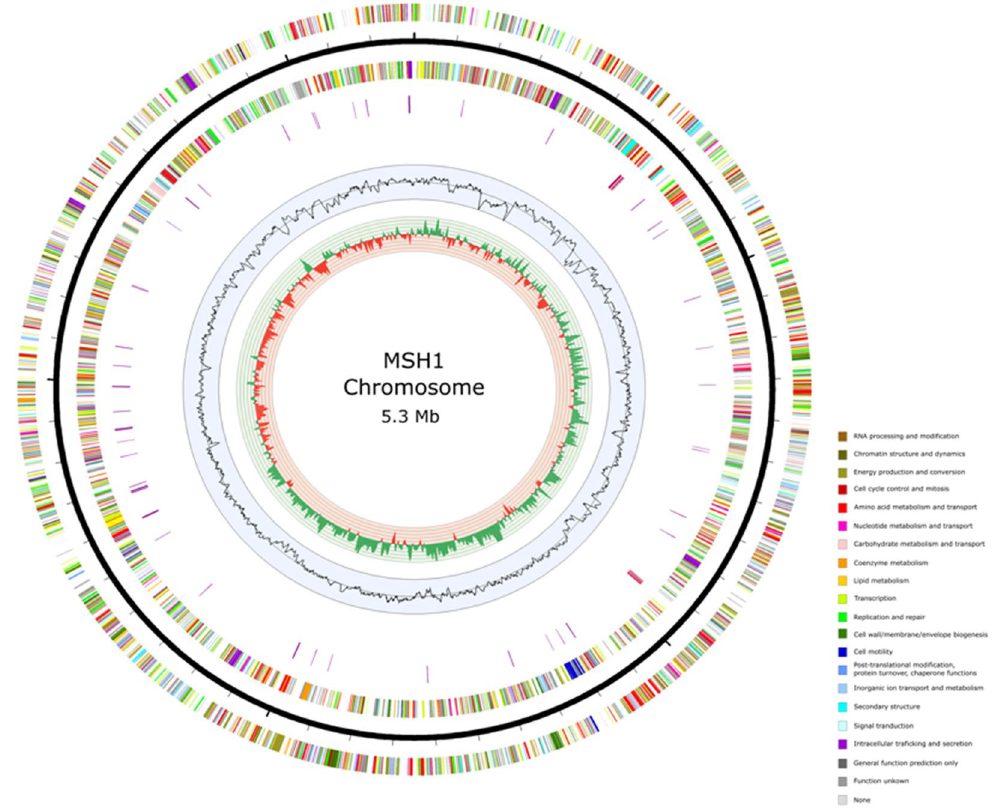
Figure 1. Circular view of the chromosome of Aminobacter sp. MSH1. From outer to inner circle: CDS on leading strand, scale (ticks: 100 kb), CDS on lagging strand, tRNA (purple) and rRNA (red) (only chromosome), GC plot and GC skew (> 0: green, < 0: red). CDS are colored according to COG functional categories determined with EggNOG mapper